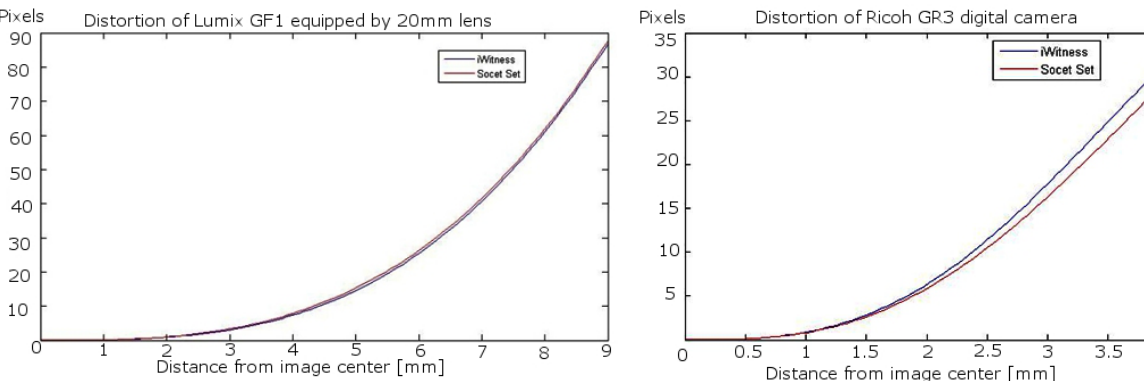
Figure 5. Radial distortions of Lumix ( left ) and Ricoh ( right ) cameras.